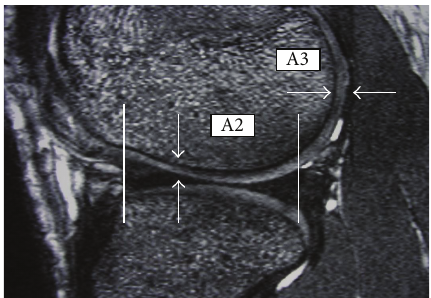
Figure 1: Mapping of MRI showing regions that are A2 and A3. White arrows show thickness in these 2 regions.